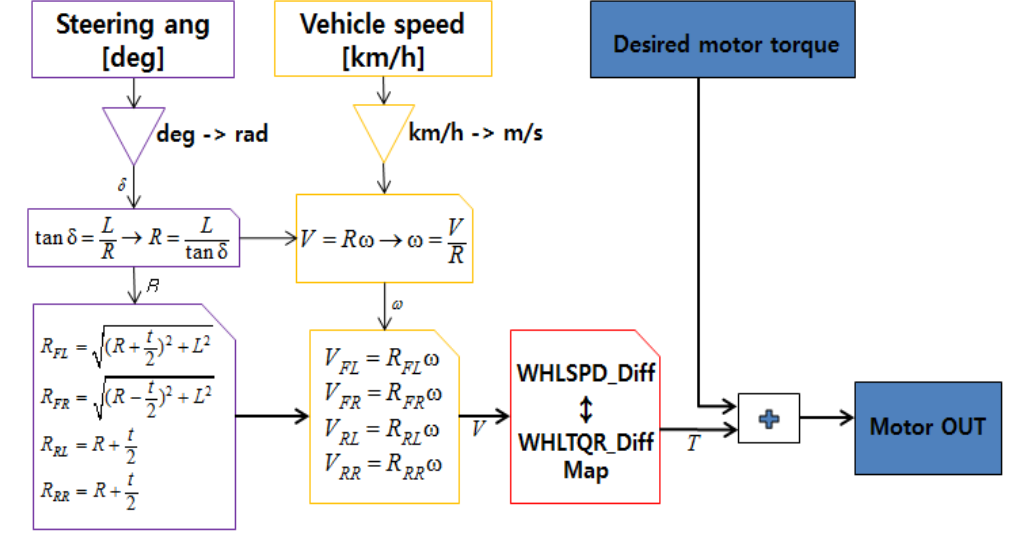
Figure 11. Control concept of electric differential gear.